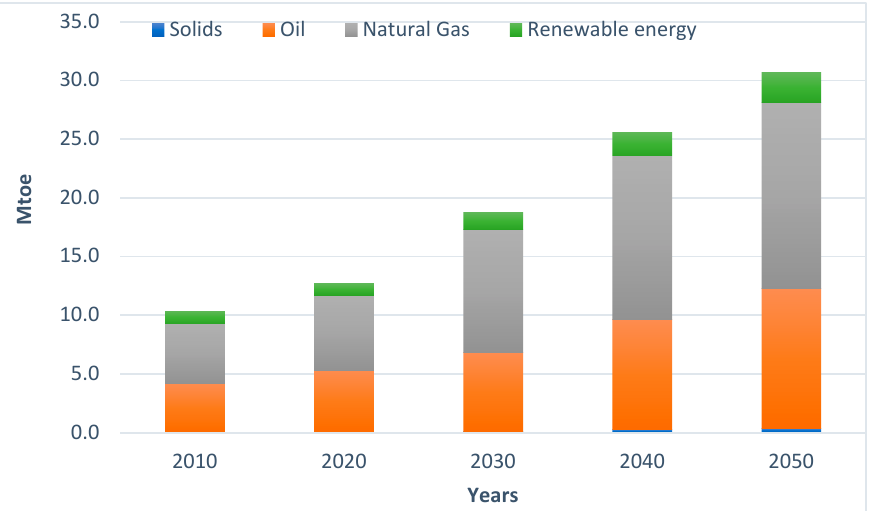
Figure 3. Gross inland energy consumption by source in Mtoe over 2010–2050 in Tunisia (BAU scenario). Source: MENA-EDS Model (BAU scenario).